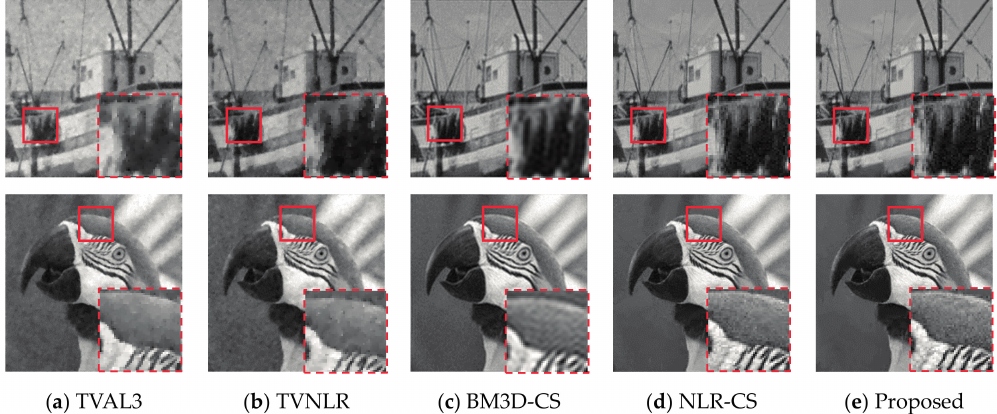
Figure 9. Comparison of reconstruction results of the Boats and Parrots images with ( a ) TVAL3, ( b ) TVNLR, ( c ) BM3D-CS, ( d ) NLR-CS, ( e ) Proposed algorithm at 20% sampling rate from noisy measurements (SNR = 25 dB). The lower right corner of the image is the selected local detail